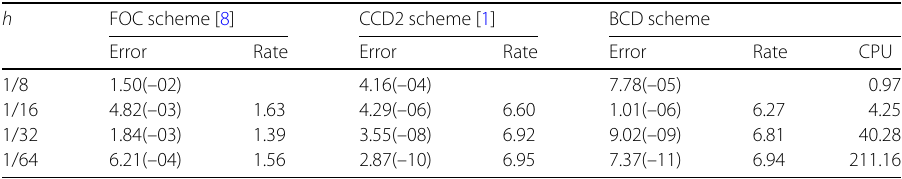
Table 6 The maximum error and convergence rate for Problem 3 with Re = 10 6 h